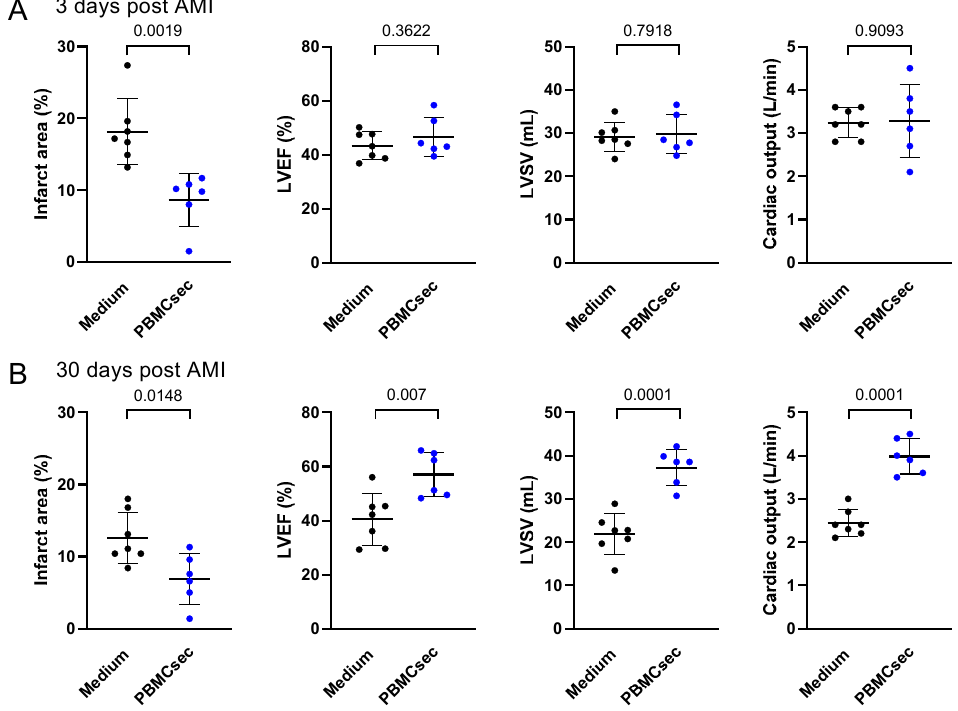
Figure 2. The PBMCsec promoted cardiac regeneration post AMI. Infarct area, LVEF, LVSV, and cardiac output of the medium-treated pigs (n = 7) and PBMCsec-treated pigs (n = 6) were assessed ( A ) 3 days and ( B ) 30 days after a LAD balloon occlusion. A two-sided t -test for unpaired samples was used to compare the groups. Numbers indicate p -values. LVEF: left ventricular ejection fraction, LVSV: left ventricular stroke volume.